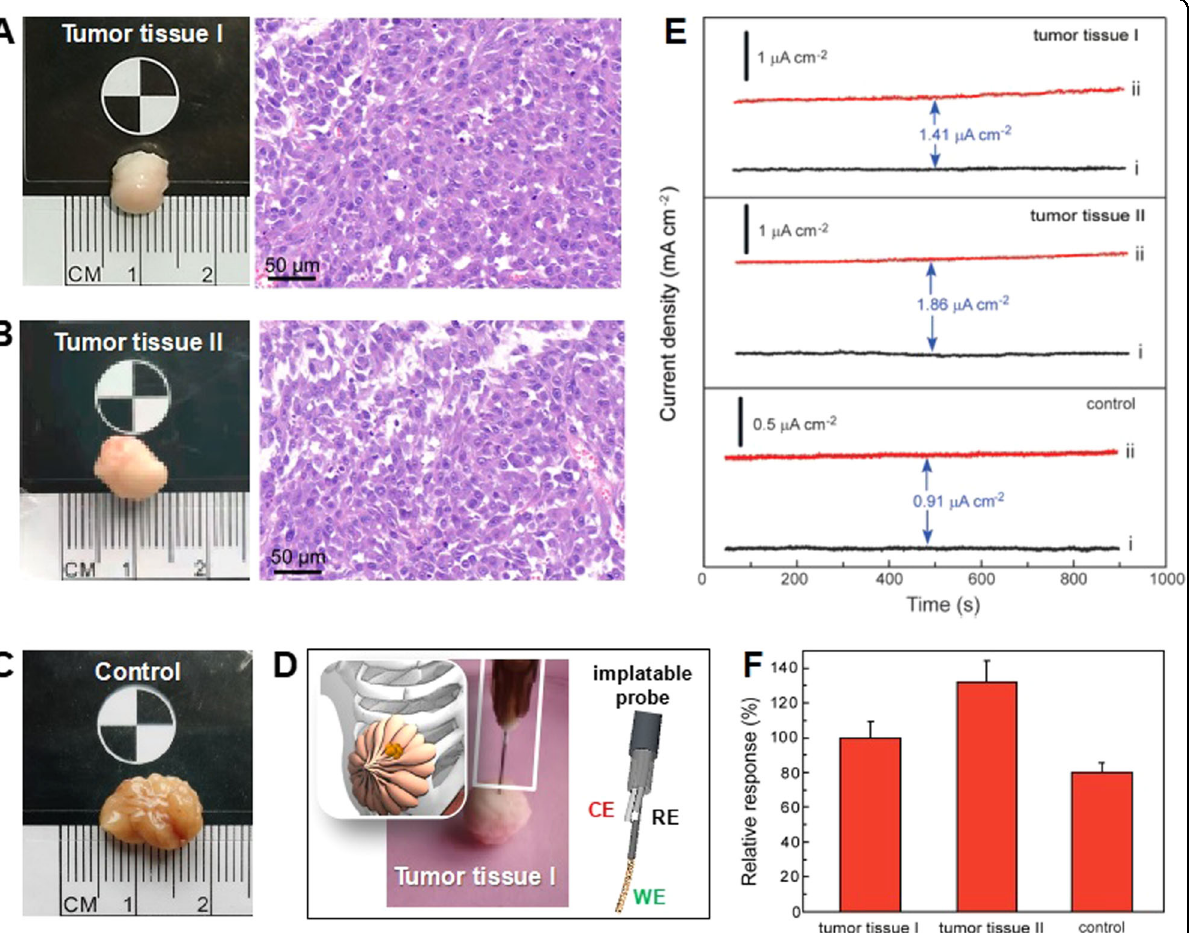
Fig. 5 In situ detection of tumor tissues by NBP-CNW-NTAs/CF based electrochemical implantable probe. A , B Digital photographs and histological microscopic images with H&E staining of different dissected breast tumor tissues from surgically resected clinical specimens. C Digital photographs of adipose tissue that enclosed tumor tissue I (control). D Digital photographs of the implantable probe for the in situ detection of breast tumor tissue and the scheme of the integrated probe with the fl exible NBP-CNW-NTAs/CF microelectrode as the WE, Ag wire as the RE and Pt wire as the CE. E Amperometric current responses of the implantable probe to the addition of 0.1mM fMLP into the test solutions containing different real human breast samples. F Histograms of the relative responses of the implantable probe to different real human breast samples under